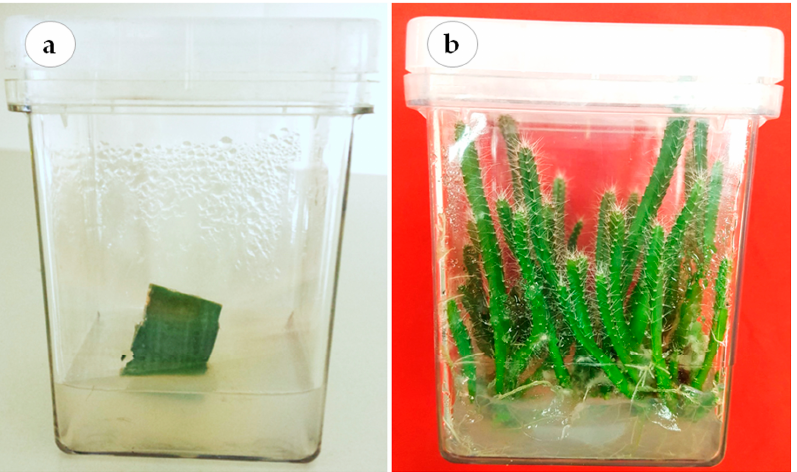
Figure 5. Establishment of H. polyrhizus in vitro culture. ( a ) Aseptic cladode segment grown on hormone-free MS medium and ( b ) in vitro axillary cladodes, used as plant materials for conducting the experiments.